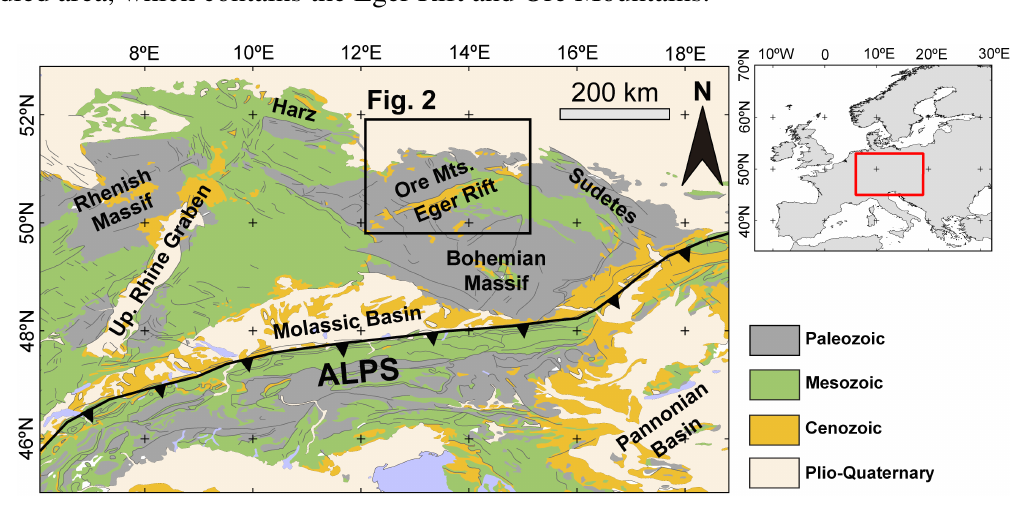
Figure 1. Simplified geological map of Central Europe. The black rectangle indicates the studied area, which contains the Eger Rift and Ore